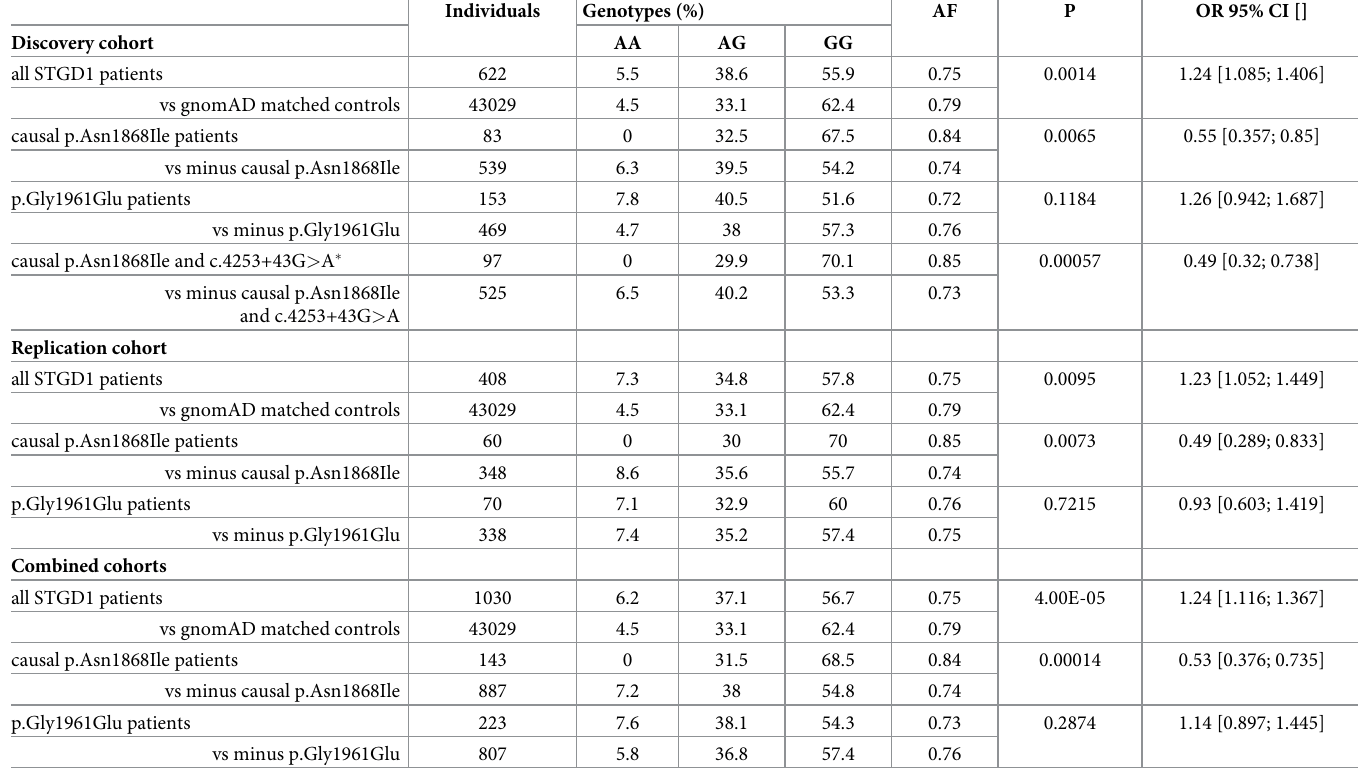
Table 4. PRPH2 c.1013A > G p.(Asp338Gly) genotype and allele frequency comparisons in ABCA4 disease cohorts and genetically determined disease subgroups. For PRPH2 , nucleotide positions and protein translation correspond to CCDS4871.1 and NP_000313.2, respectively; for ABCA4 , CCDS747.1 and NP_000341.2, respec- tively. Nucleotide numbering uses the A of the ATG translation initiation start site as nucleotide 1. All comparisons were performed with the two-sided FET. P, uncor- rected p-values. Bonferroni correction resulted in the significance thresholds of p = 0.05/4 = 0.0125 for the Discovery cohort and p = 0.05/3 = 0.017 for the Replication and Combined cohorts. AF, allele frequency; P, unadjusted p-value; gnomAD, genome aggregation database. � Replication cohort did not include the data for the c.4253 +43G > A